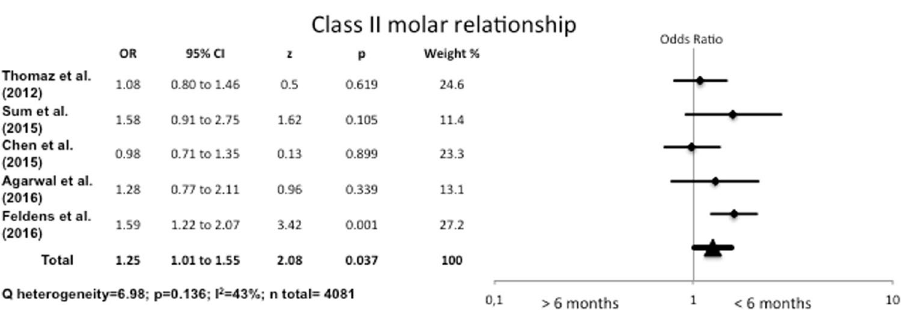
Figure 6. Odds Ratio for Class II molar relationship, comparing breastfeeding for < 6 months with breastfeeding for > 6 months.